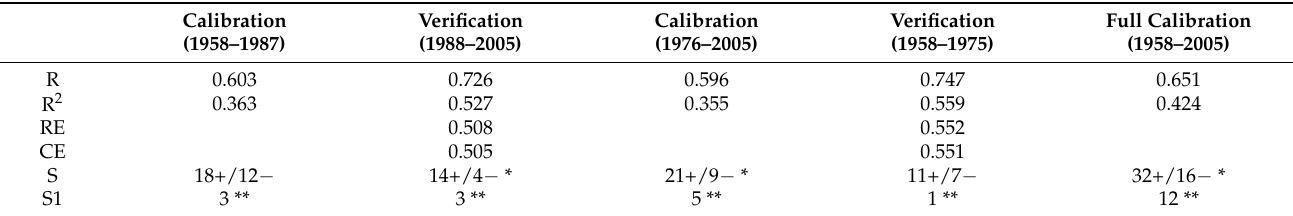
Table 3. Test statistical results of the reconstruction equation.